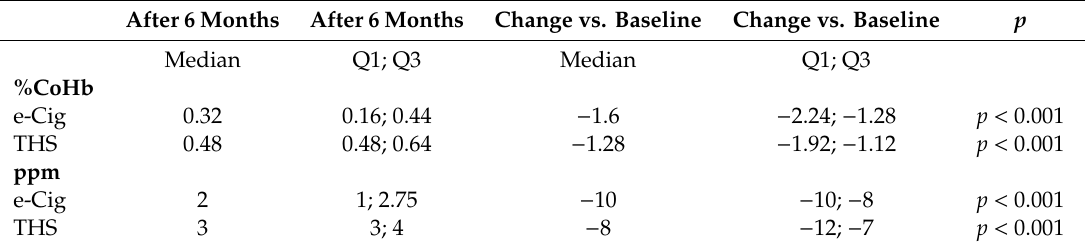
Table 2. eCO data six months after switching and change vs baseline (Q1 = quartile 1; Q3 = quartile 3). After 6 Months After 6 Months Change vs.